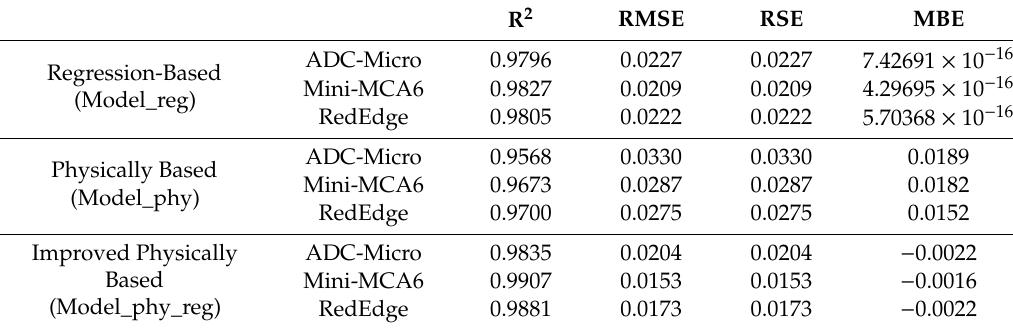
Table 5. Measures of R 2 , RMSE, RSE, and